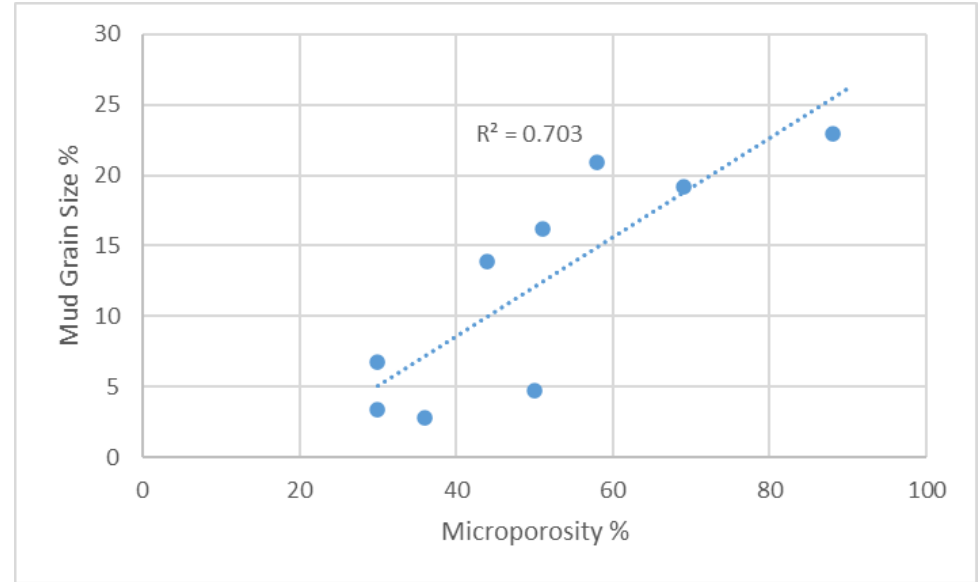
Figure 24. Scatter plot of visual microporosity and mud size.